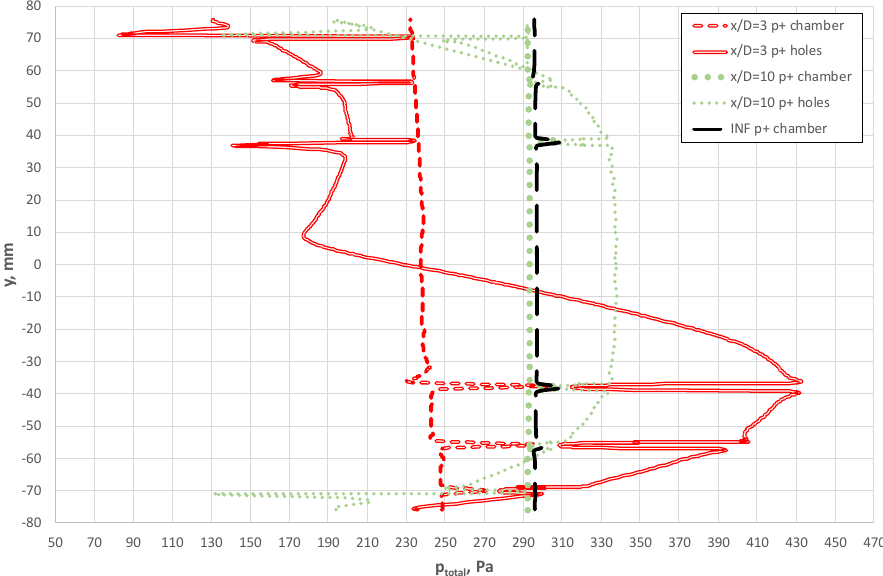
Figure 14. Total pressure along the axis of the p + chamber and along the line that combines the p + holes on the side of the probe.